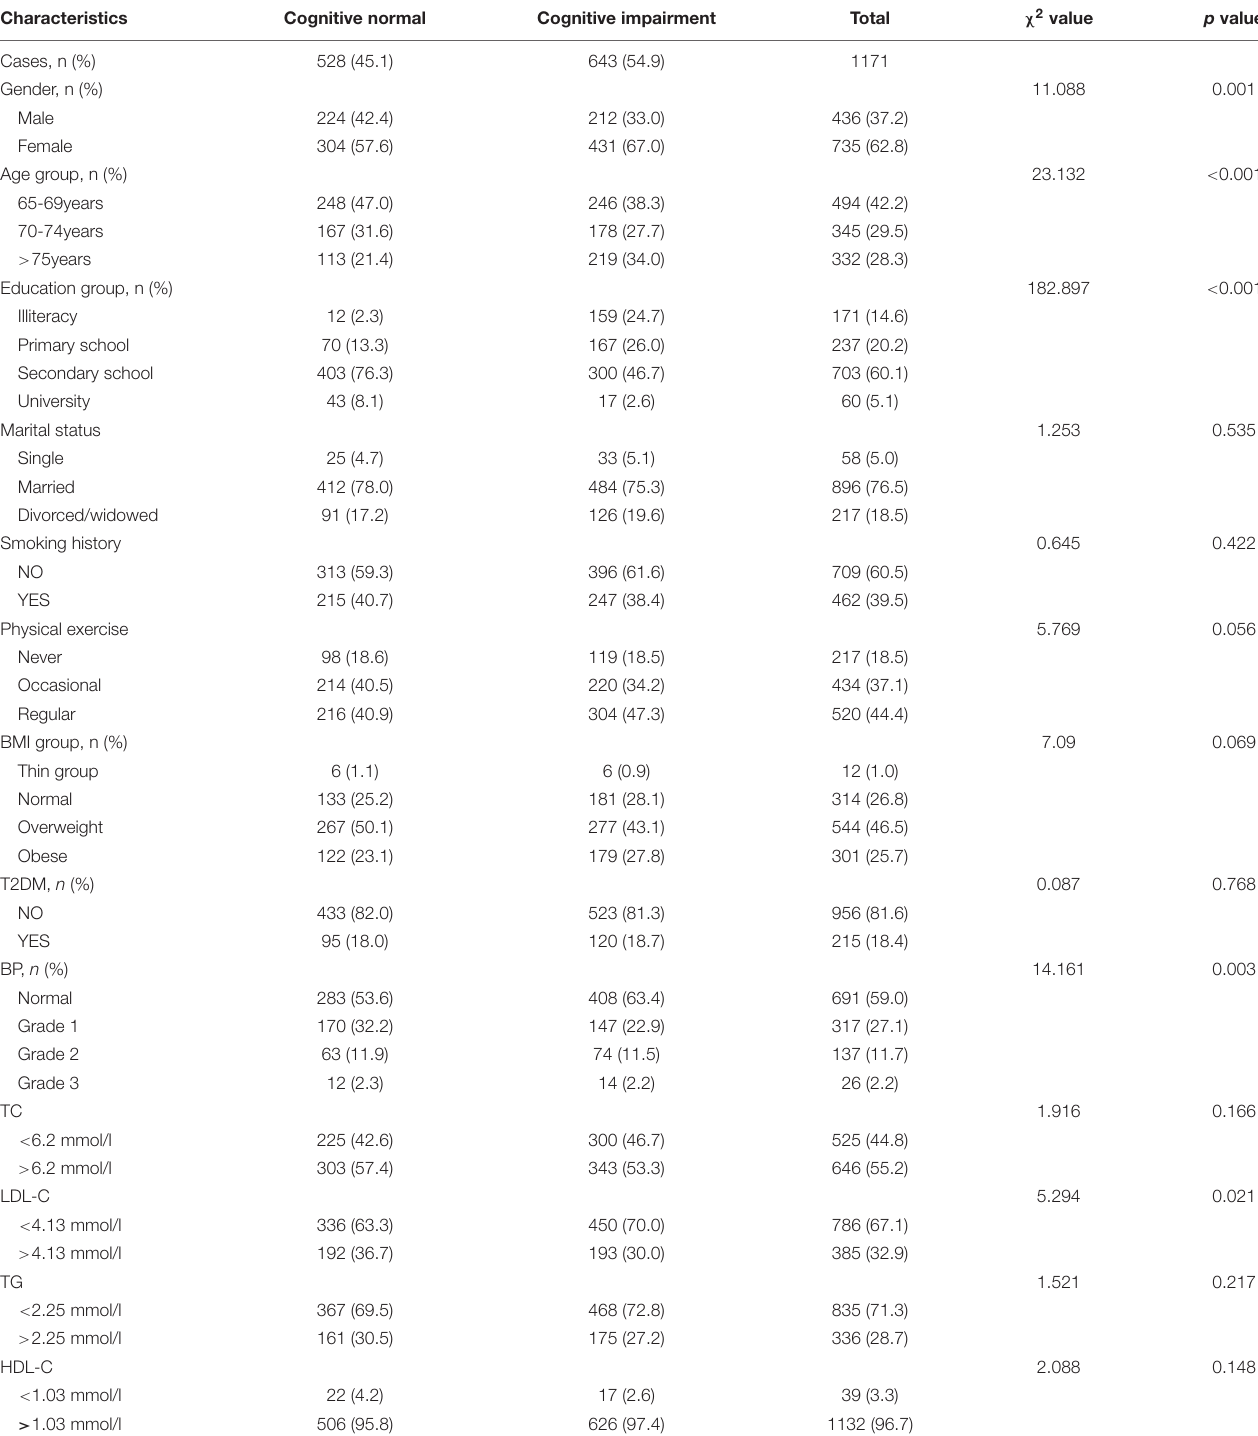
TABLE 1 | Basic situation and cognitive impairment of the elderly in three communities, China, 2016.